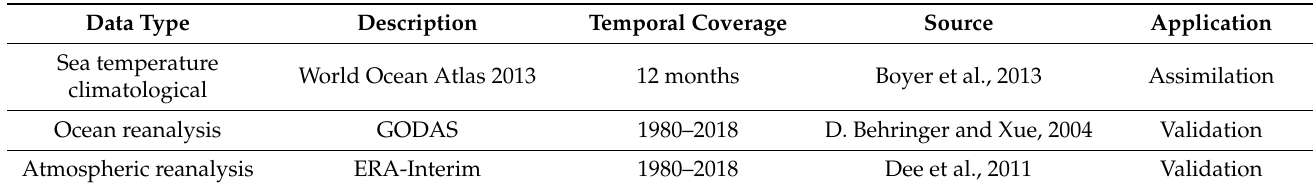
Table 1. Datasets used in this